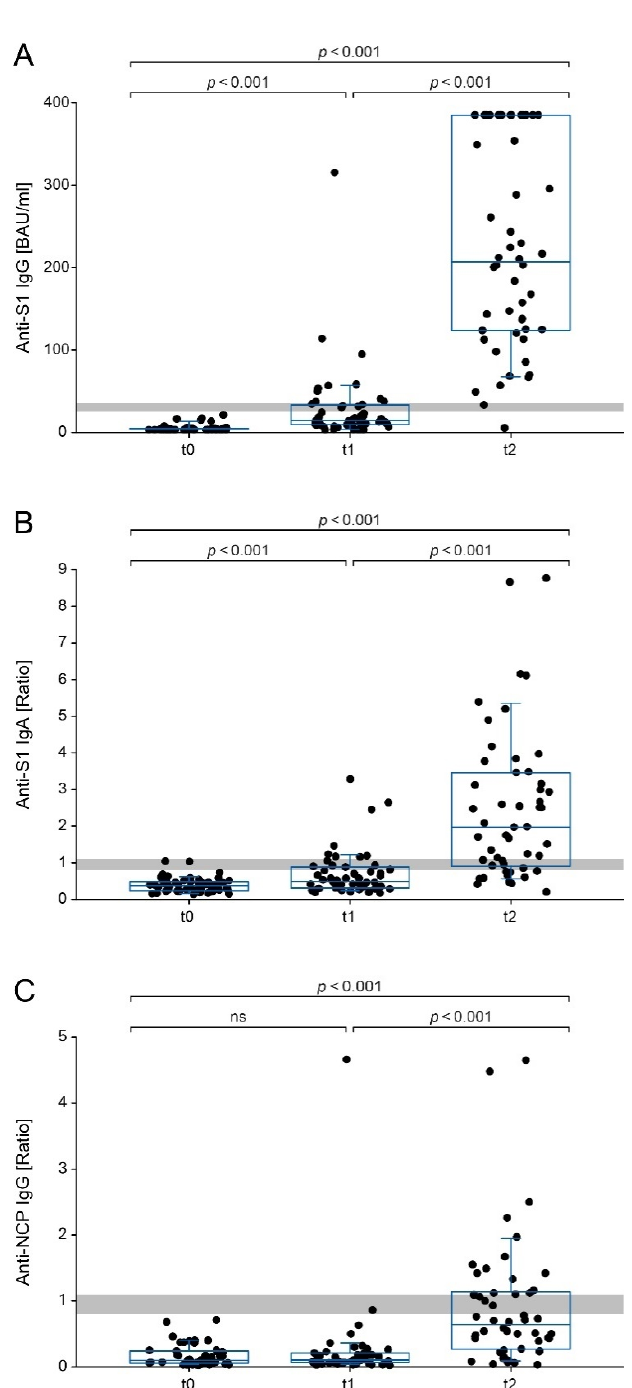
Figure 1. ( A ) Anti-S1 IgG, ( B ) anti-S1 IgA and ( C ) anti-NCP IgG reactivity in 50 vaccinees at baseline (t0), 4 weeks after the first dose (t1), and 2 weeks after the second dose of CoronaVac (t2). Data are presented as scatter plots, boxes indicate interquartile ranges (outer bounds) and medians (midlines). Whiskers present the 90th and 10th percentiles. Borderline ranges are shaded in grey. The Wilcoxon signed-rank test was used to analyze differences in antibody levels between the time points (ns, not statistically significant). For anti-S1 IgG, samples with results above the measurement range (>384 BAU/mL) are indicated as data points at 385 BAU/mL.